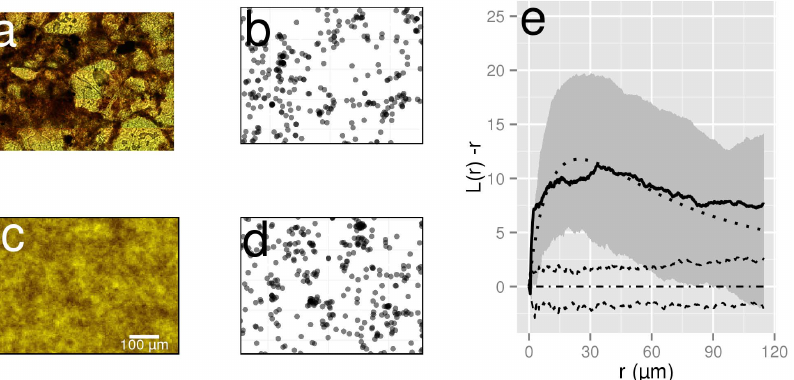
Figure 1. Bacterial habitat, observed and simulated distribution of bacteria in a soil thin section. (a) Bright field image of a soil thin section showing various soil features that characterise the soil microbial habitat and (b) bacterial distribution observed in the same thin section. (c) Random probability field generated using parameters estimated from b ( m = 2 7.64; s 2 =2.0 and b =12.95) and (d) simulated bacterial distribution using c. as random intensity (LGCP model). Colours for the random field were chosen to match those of the thin section image. Darker shades indicate higher probability of bacterial presence. The scale for all panels is identical and is indicated in c. (e) Transformed Ripley functions L(r) - r for the observed bacterial distribution shown in a. (solid line) and envelopes of 99 simulations under CSR and LGCP. The dashed lines indicate the envelope of CSR simulations of the same intensity as a. and the shaded area the envelope of simulations of an LGCP with parameters estimated from the observed point distribution. The dotted line corresponds to the theoretical functions under LGCP and the dashed-dotted line to the theoretical function under CSR. In e., L(r)-r above 0 indicates that the point pattern is more aggregated than a random process.